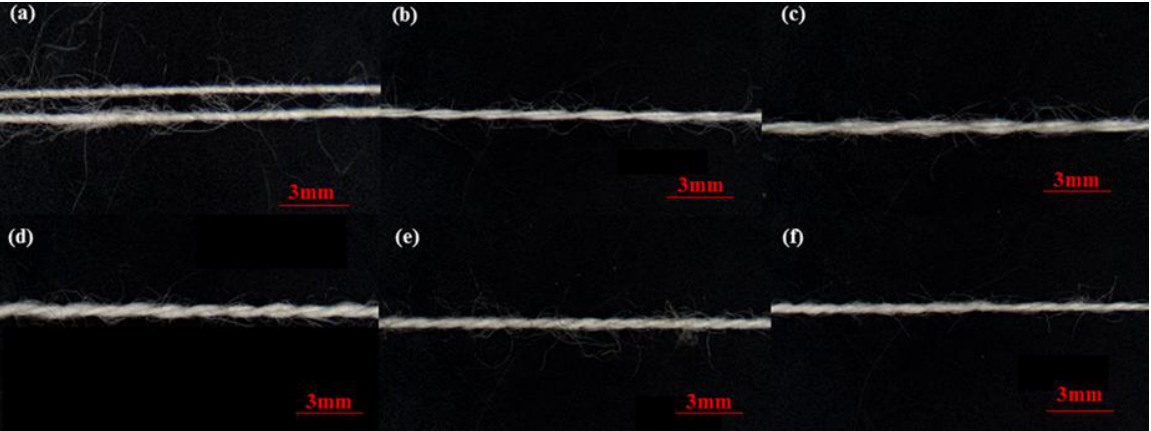
Figure 2. Two-plied zinc yarns: ( a ) 2Zn-0C, ( b ) 2Zn-1C, ( c ) 2Zn-2C, ( d ) 2Zn-3C, € 2Zn-4C, and ( f ) 2Zn-5C.